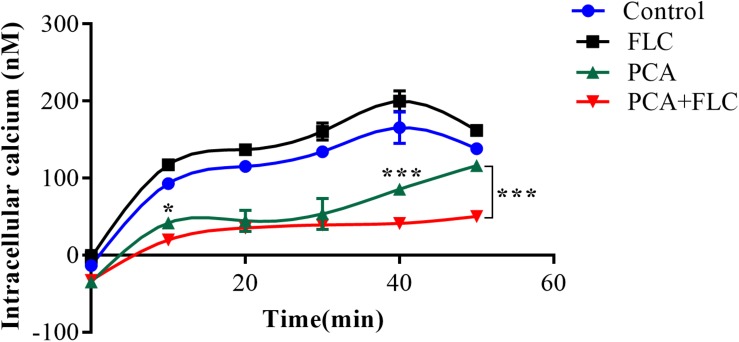
Fluctuation of intracellular calcium concentration in Candida albicans. CA10 cells with Fluo-3/AM staining were analyzed by the flow cytometry after treatments with different drugs (1 μg/ml fluconazole (FLC), 64 μg/ml D-penicillamine (PCA), 1 μg/ml FLC + 64 μg/ml PCA and control). The data came from the means of three independent experiments. ∗P < 0.05, ∗∗∗P < 0.001.